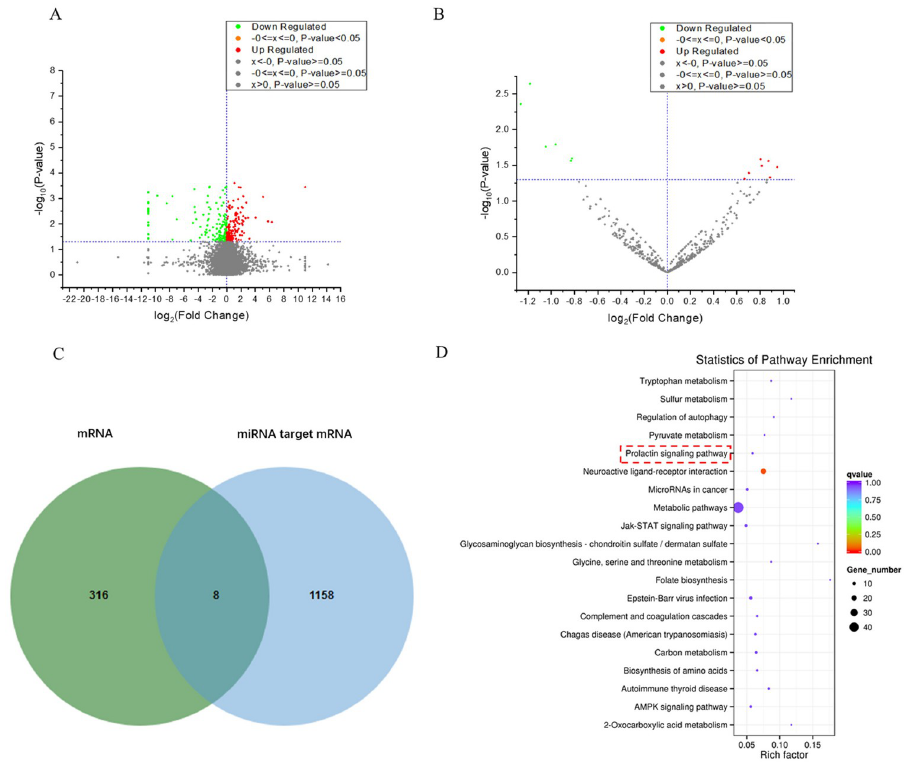
Fig 2. Analysis differentially expressed mRNAs and miRNAs. (A) Differentially expressed mRNA volcano plot, (B) Differentially expressed mRNA volcano plot, (C) Venn diagram between differentially expressed mRNA and miRNA targeted mRNA, (D) were the KEGG pathway enriched in differentially expressed